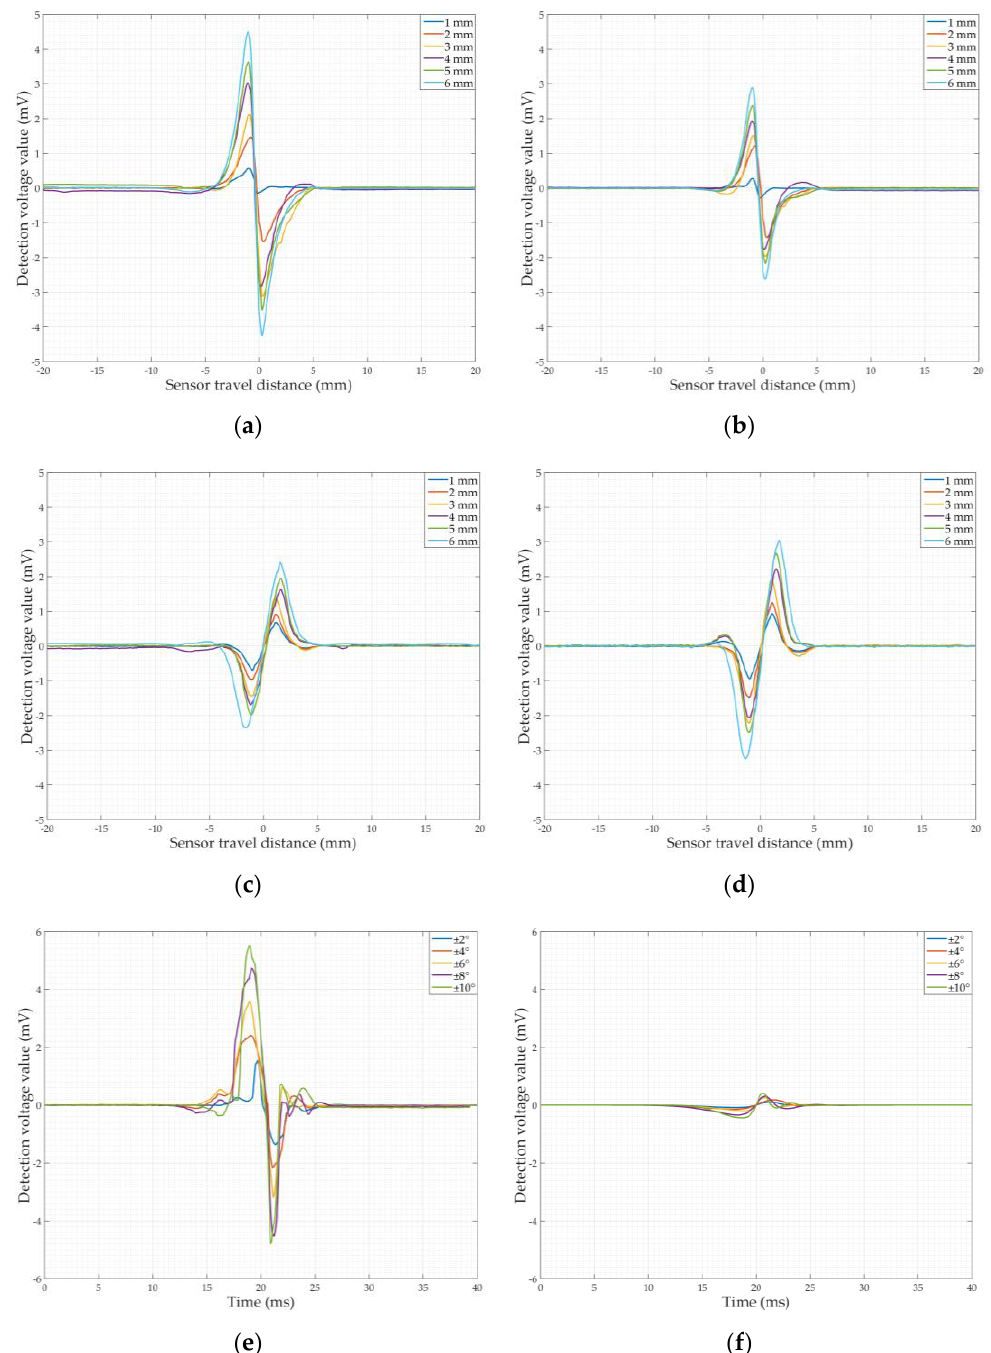
Figure 11. Signals of detection experiments: ( a ) In-phase detection signals of circumferential cracks; ( b ) Orthogonal detection signals of circumferential cracks; ( c ) In-phase detection signals of axial cracks; ( d ) Orthogonal detection signals of axial cracks; ( e ) In-phase components of detection signal generated by sensor jitter; ( f ) Orthogonal components of detection signal generated by sensor jitter.